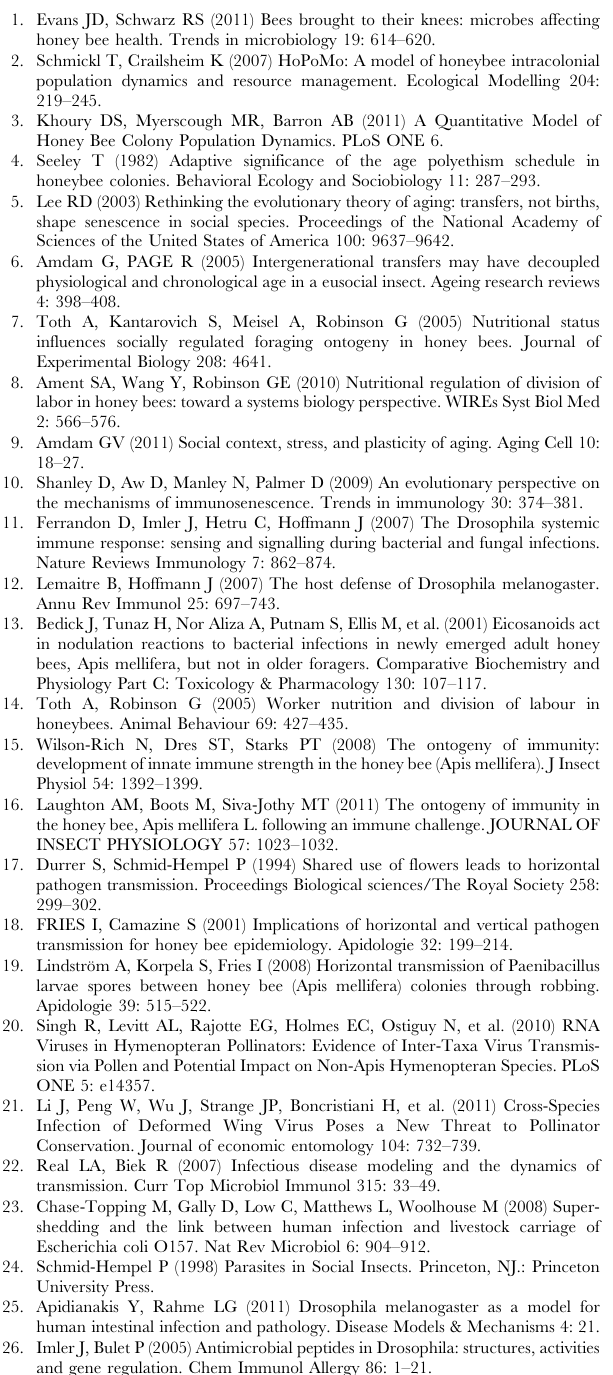
tissue from bees that were positive ( + ) or negative ( 2 for Nosema ceranae . Boxes show 1st and 3rd interquartile range with line denoting medians. Whiskers encompass 95% of the individuals. Outliers are denoted with filled